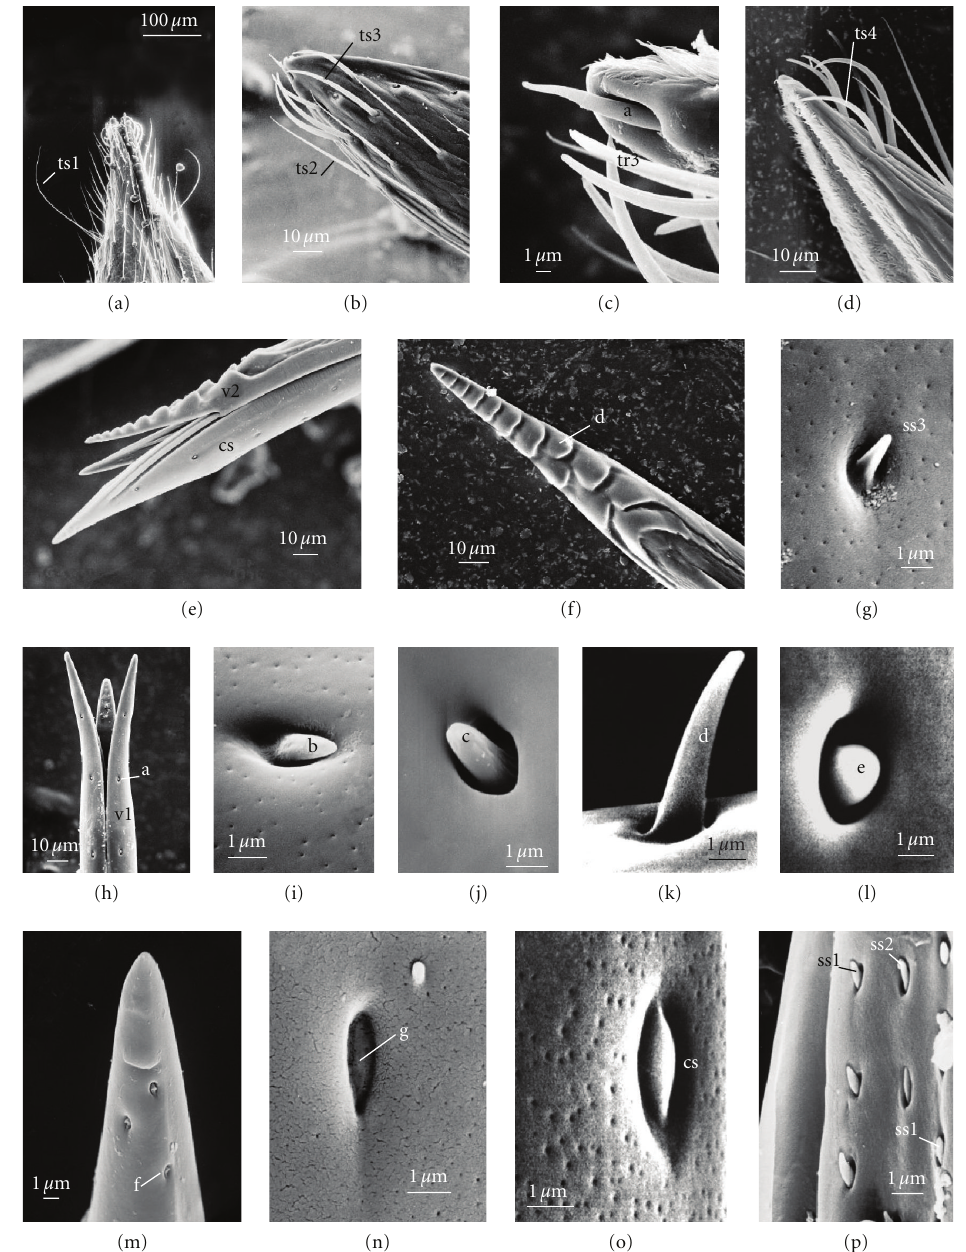
Figure 2: Ovipositor of A. procerae . (a) Extremity of the abdomen of A. procerae showing the valvulae at the distal end of the stylet. ts1: trichoid sensillum of type 1. (b) External surface of the distal end of a 3rd valvula bearing several types of trichoid sensillae; ts2: trichoid sensillum of type 2; ts3: trichoid sensillum of type 3. (c) Extremity of a 3rd valvula showing 3 sensillae of type 3. a: sensillum of type a. (d) Internal surface of the distal end of a 3rd valvula, viewed in profile. The interior of the valvula is empty. A trichoid sensillum of type 4 is seen. ts4: trichoid sensillum of type 4. (e) Distal extremity of the stylet of the ovipositor viewed in profile. The 2nd valvulae are carried by the 1st valvulae. v2: 2nd valvula; cs: campaniform sensillum. (f) Distal end of the dorsal surface of a 2nd valvula showing 10 denticulations making a united lancet. d: denticulation. (g) Styloconic sensillum of type 3 on the external surface of the proximal part of a valve 2. ss3: styloconic sensillum of type 3. (h) Distal extremity of the ventral part of the stylet of the ovipositor viewed in front. v1: valve 1; a: campaniform sensillum of type a. (i) Sensillum of type b located on the half proximal part of the external surface of a valve 1. b: sensillum of type b. (j) Sensillum of type c located on the half proximal part of the external surface of a valve 1. c: sensillum of type c. (k) Sensillum of type d, observed on the external surface of the proximal part of a valve 1. d: sensillum of type d. (l) Sensillum of type e, located at 120 μ m of the distal extremity of a valve 1. e: sensillum of type e. (m) External surface of the distal extremity of a valve 1. The three sensillae of type f are distributed in triangle. f: sensillum of type f. (n) Sensillum of type g located at the half proximal part on the external surface of a valve 1. g: sensillum of type g. (o) Campaniform sensillum located at the 2/3 proximal of the a valve 1. cs: campaniform sensillum. (p) Three rows of styloconic sensillae of type 1 and 2 on the external surface of the distal extremity of a valve 3. ss1: styloconic sensillum of type 1; ss2: styloconic sensillum of type